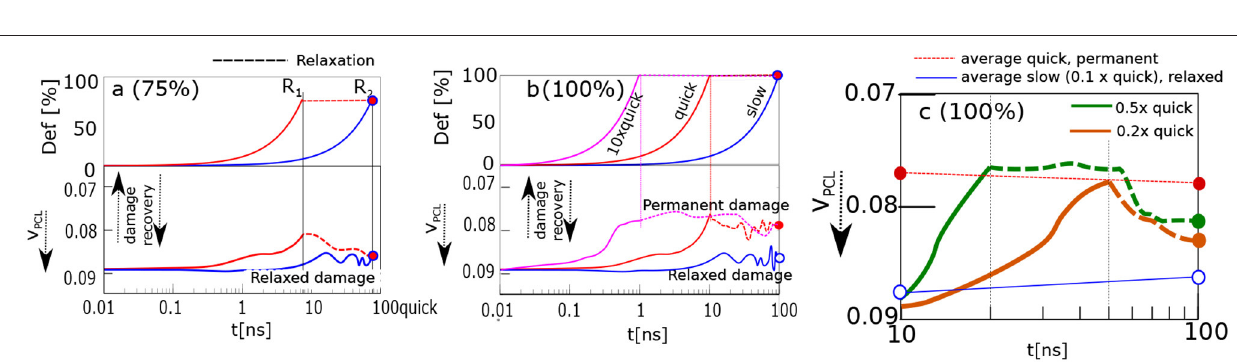
where x is a specific property at zero time and at time t . Observables are the inertia (velocity vector), bond/angle relaxation (bond vector), conformation relaxation (bond vector), relaxation of physical clusters (probability of presence in physical cluster) and relaxation of bundles and fibrils